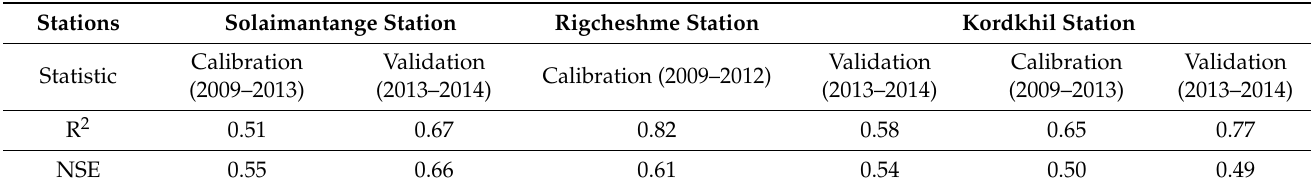
Table 4. Model evaluation statistics for the calibration and validation of